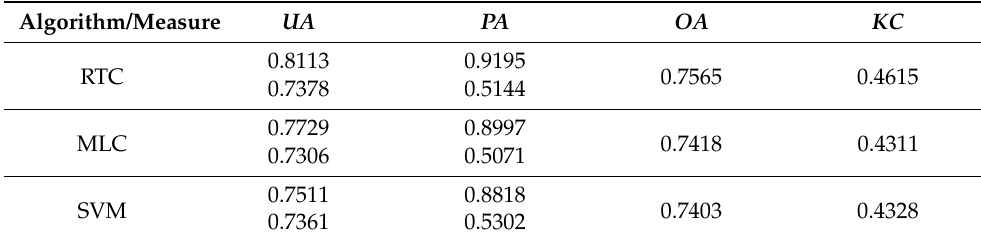
Table 2. GEOBIA accuracy assessment measures